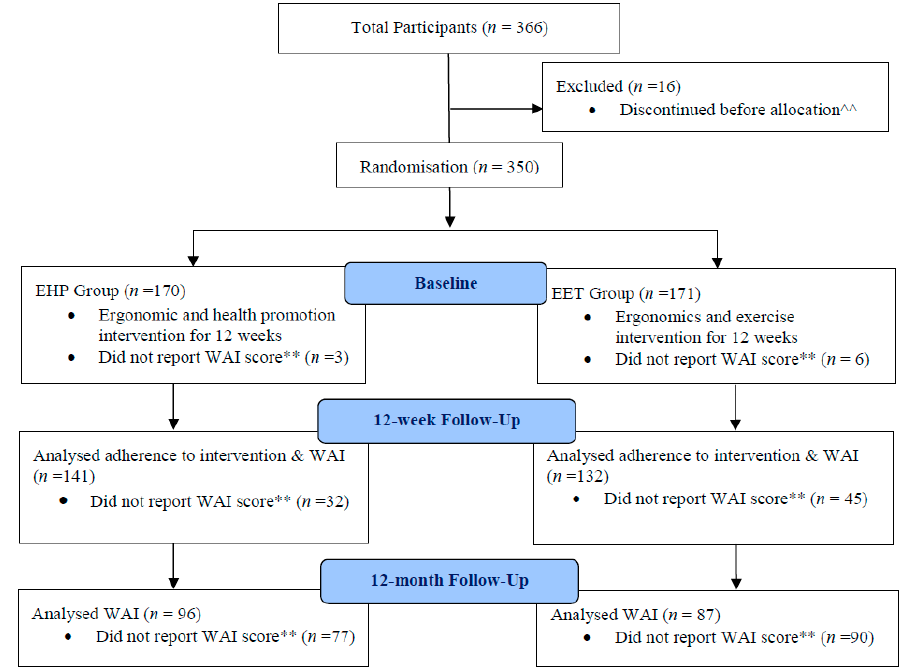
= Work Ability; ˆˆ 16 Participants